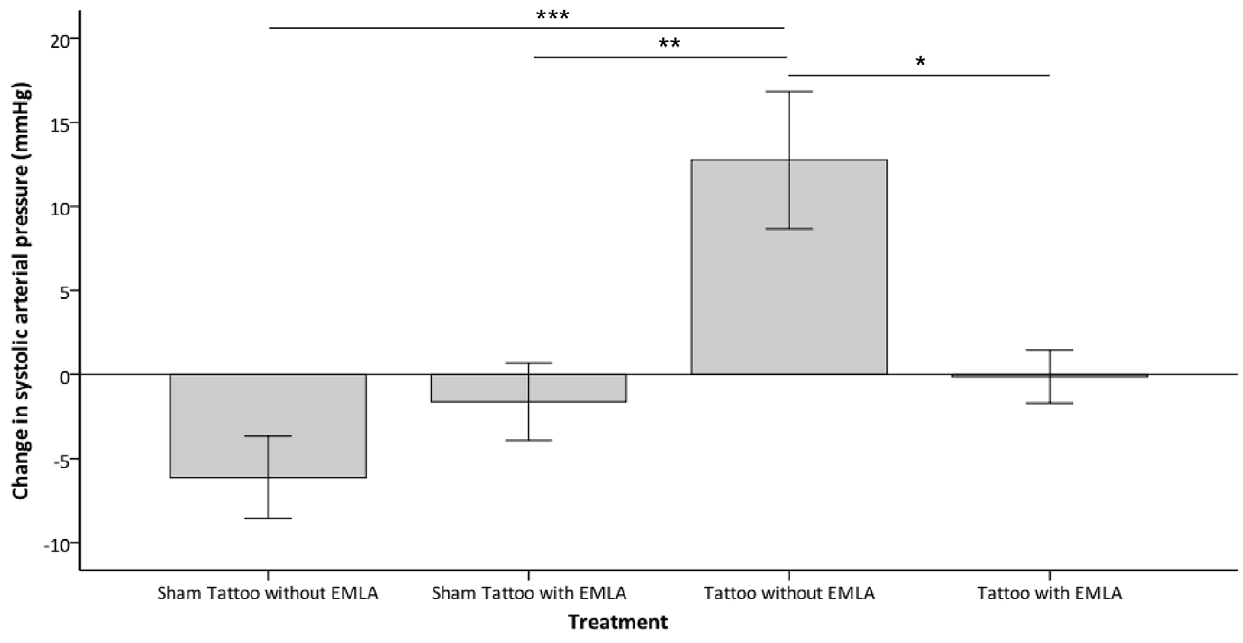
Figure 2. Change in mean systolic arterial pressure (SAP) from pre to post-procedure. Change in mean systolic arterial pressure (mmHg 6 1 SE) from pre to post-procedure observed in rabbits (y-axis) when undergoing the various treatments (x-axis); sham tattooing with and without prior application of EMLA and tattooing with and without prior application of EMLA (n=8 per treatment) ( w P=0.024, ww P=0.028, www P=0.003).